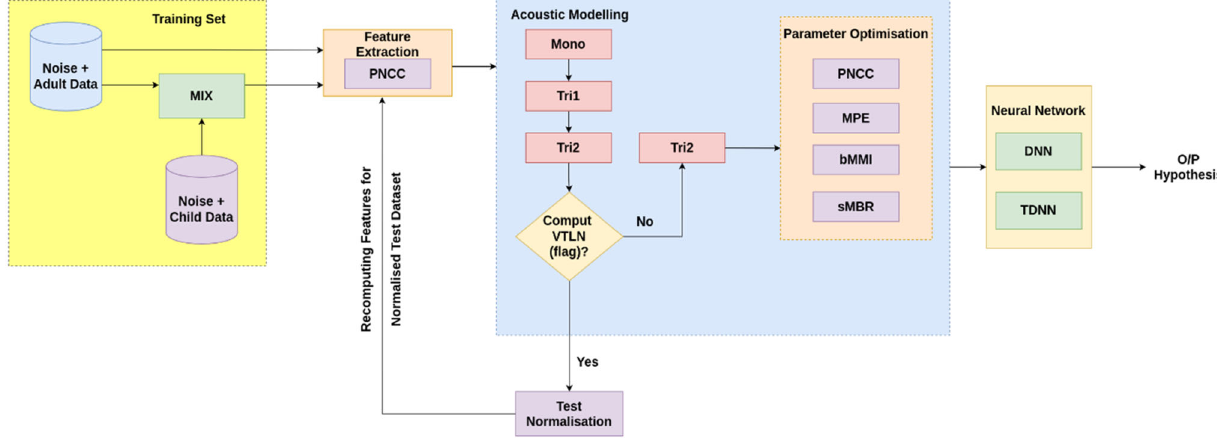
Fig. 5 BasicblockdiagramofrobustASRframeworkonvocallengthnormalized-inducedfront-endapproachusingvaryingdiscriminativesequence training on mismatched systems